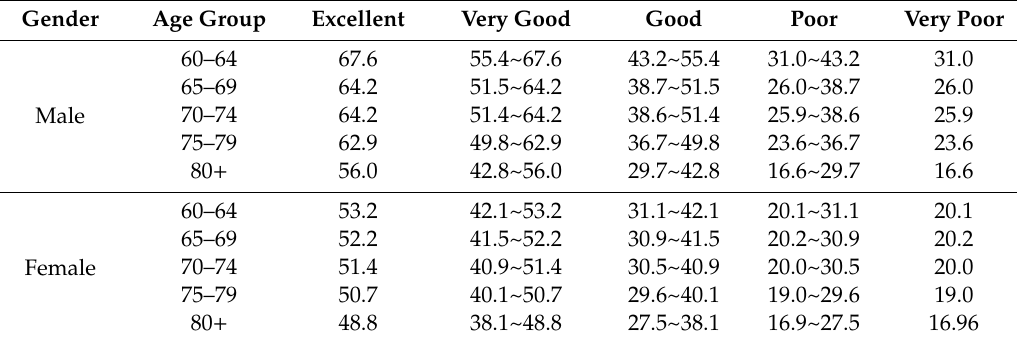
Table 16. Relative grip strength 5-grade relative evaluation norms, Unit: %.